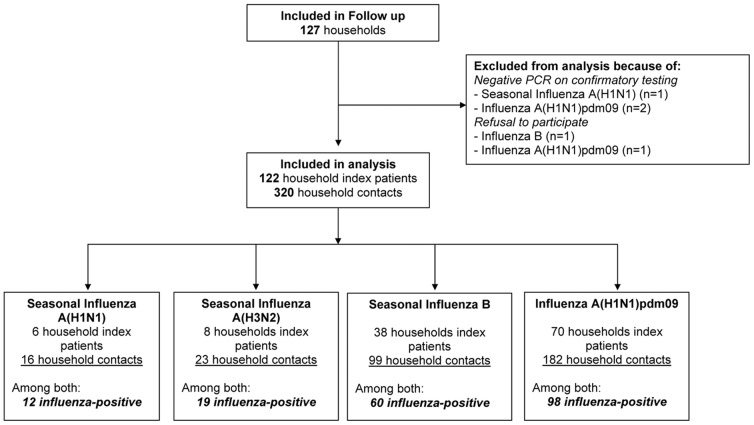
Study flow diagram.